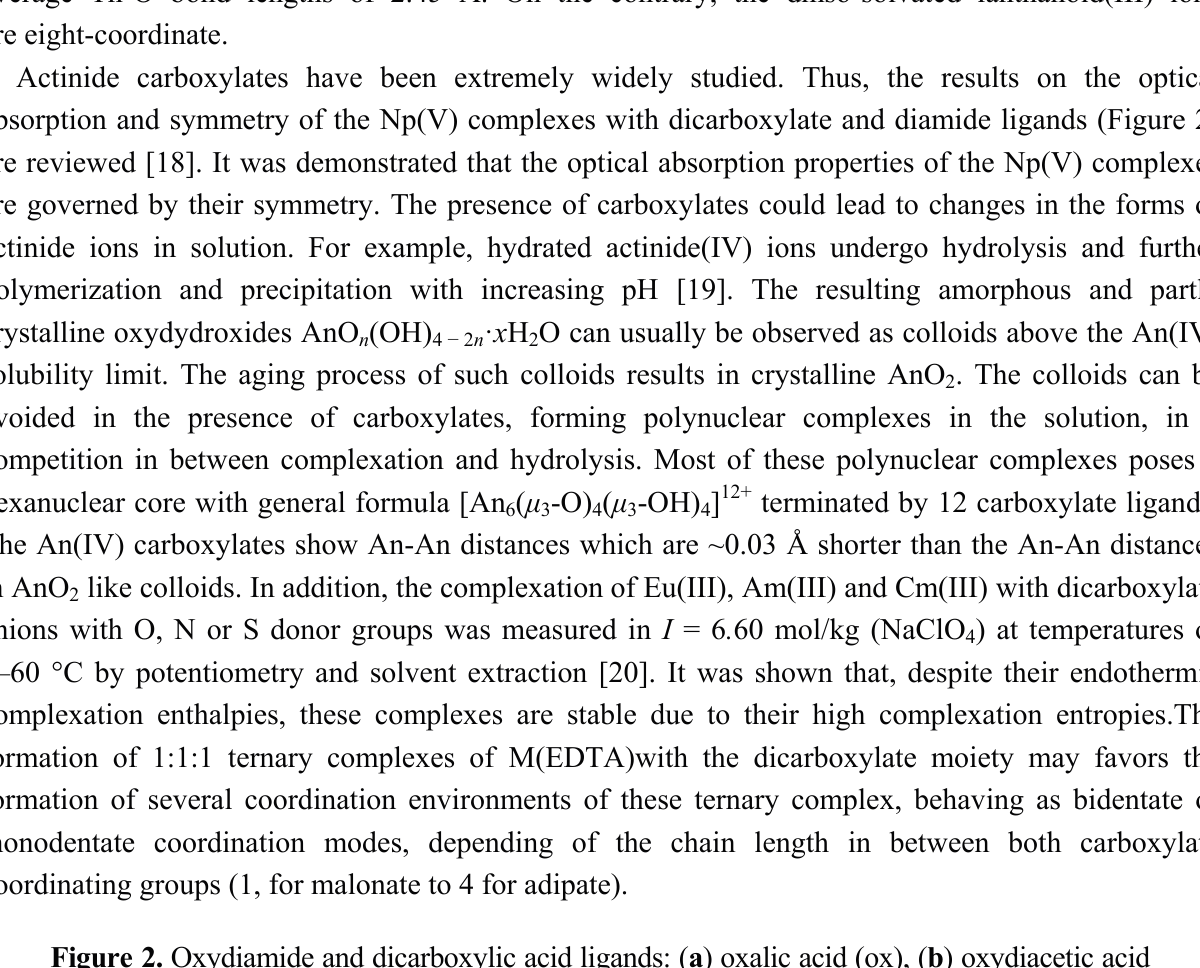
Figure 2. Oxydiamide and dicarboxylic acid ligands: ( a ) oxalic acid (ox), ( b ) oxydiacetic acid (ODA), ( c ) iminodiacetic acid (IDA), ( d ) dipicolinic acid (DPA), ( e ) N methyliminodiacetic acid (MIDA), ( f ) N , N , N ', N '-tetramethyl-3-oxa-glutaramide